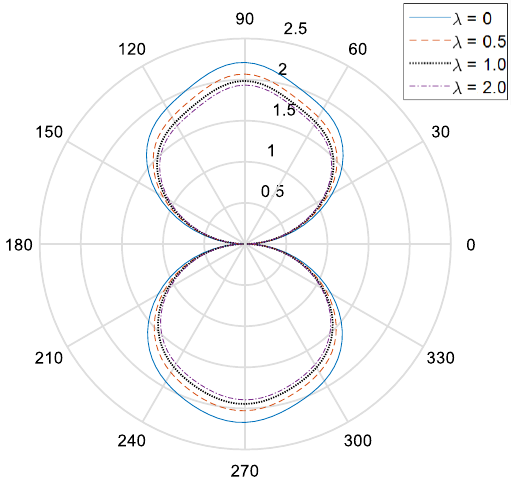
Figure 2. Dynamic stress concentration factor around a single opening in piezomagnetic composites ( ka = 0.1, λ = (0, 0.5, 1.0, 2.0)).